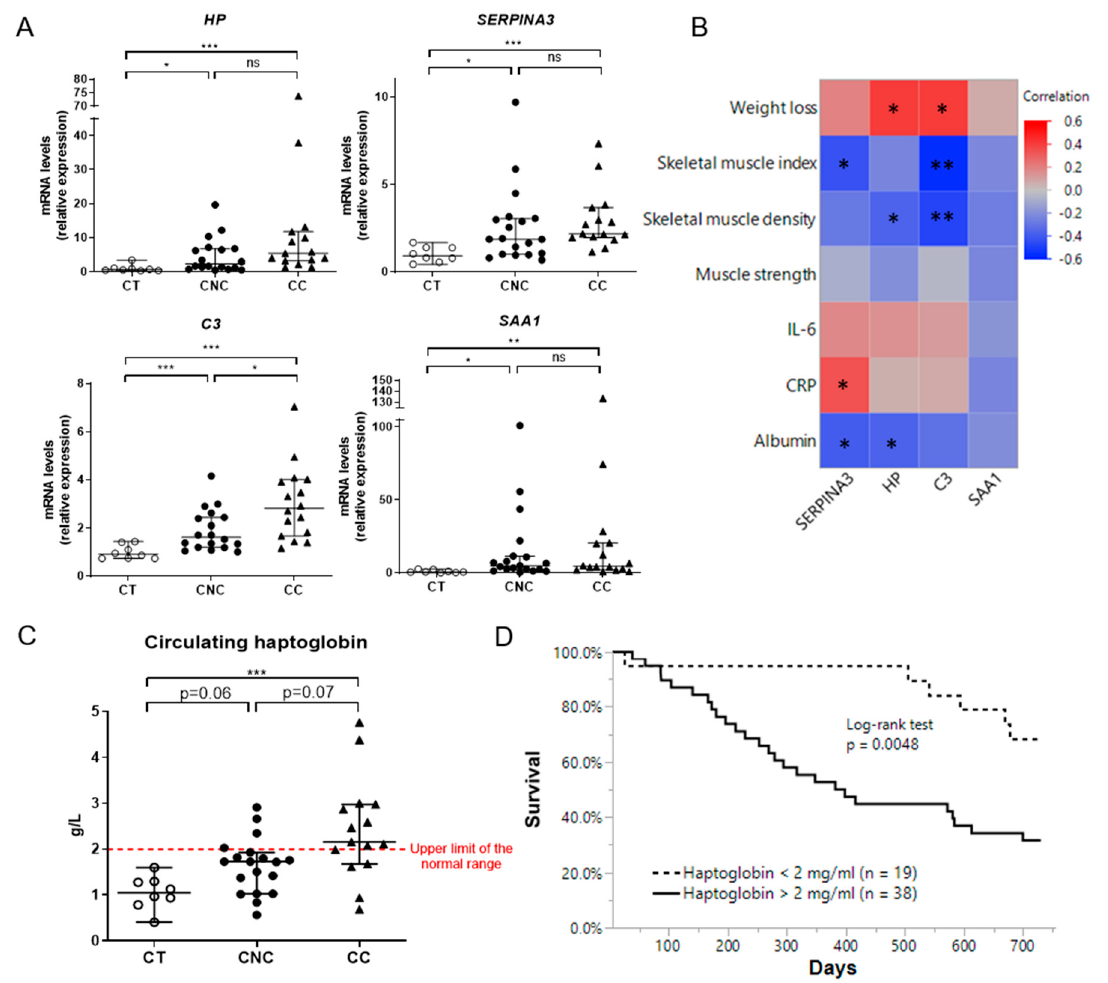
Figure 6. Muscle expression of acute phase reactants (APR) is increased in cancer patients and is inversely correlated with muscle index and muscle density. ( A ) HP , SerpinA3 , C3 , and SAA1 mRNA relative levels in quadriceps biopsies of healthy subjects (CT), non-cachectic (CNC), and cachectic (CC) cancer patients. ( B ) Heatmap showing the Pearson correlation coe ffi cients between muscular expression of four selected acute phase reactants in CNC and CC patients ( n = 35) and, respectively, weight loss (%), skeletal muscle index (cm 2 / m 2 ), skeletal muscle density (HU), muscle strength corrected with values for the 50th percentile (kg / kg) and circulating levels of IL-6, CRP, and albumin. Circulating HP concentrations are increased in CC patients and are predictive of poor survival. ( C ) Circulating levels (g / L) of HP in CT subjects, CNC and CC patients. Data are reported as median ± 95% confidence interval (CT, n = 8; CNC, n = 19; CC, n = 15). ( D ) Kaplan–Meier survival curves according to plasma haptoglobin levels (two groups determined with normal values range of haptoglobin: 2 mg / mL) for lung cancer patients ( n = 57). Significance was determined by logrank test. * p < 0.05, ** p < 0.01, and *** p <